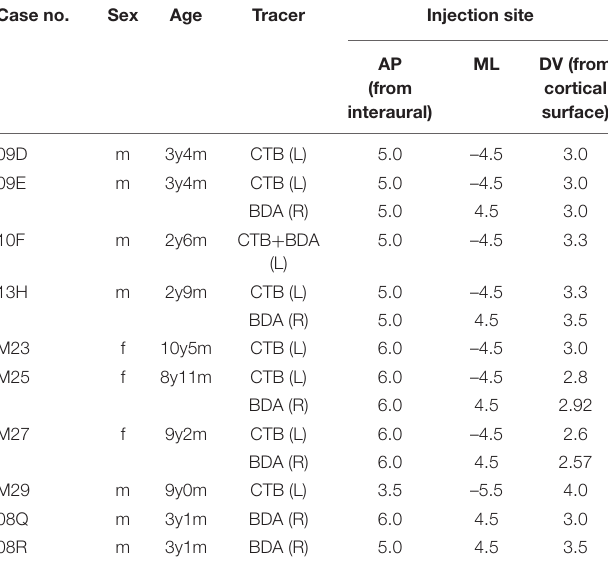
TABLE 1 | Summary of tracer injections described in